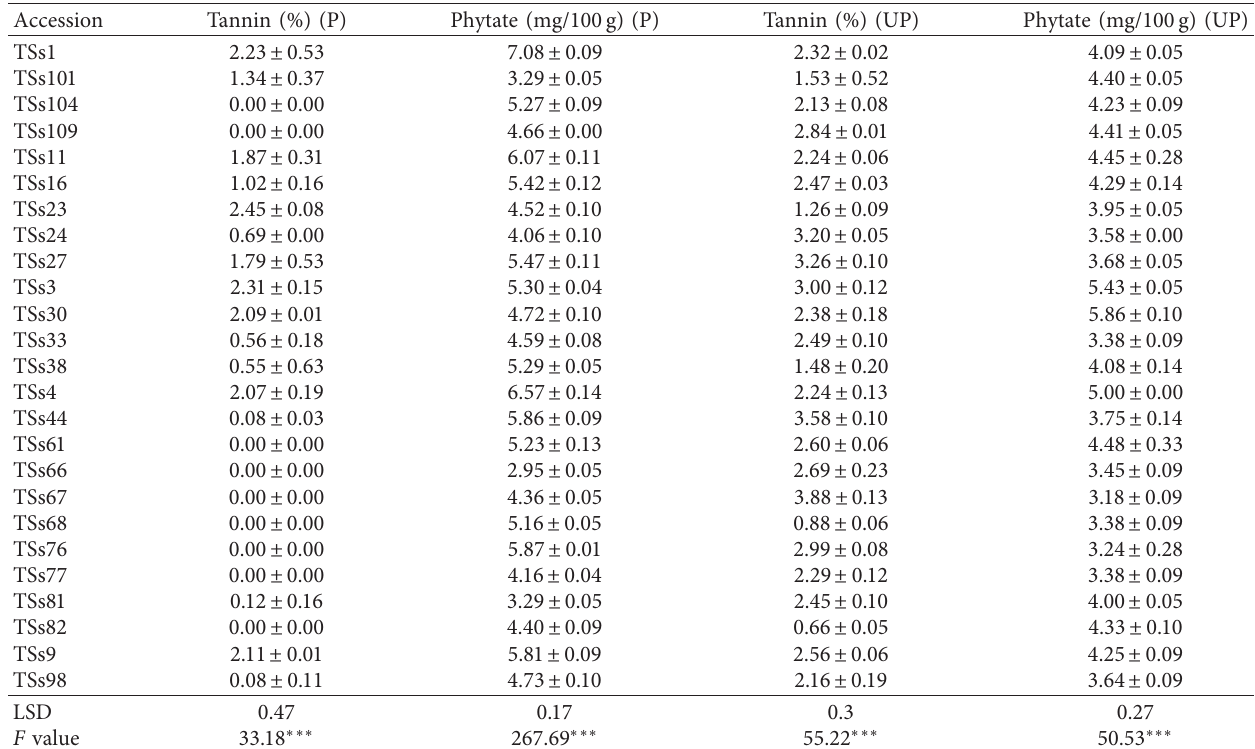
Table 4: Means ± standard deviation of antinutrients of processed (P) and unprocessed (UP) African yam bean flour. Accession